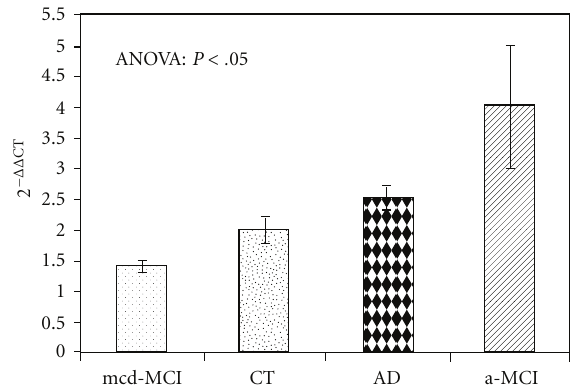
Figure 1: A 2A R mRNA levels (mean values ± standard error) in PBMCs from 41AD, 10 a-MCI, 49mcd-MCI, and 46 control (CT) subjects quantified by the 2 − ΔΔ Ct method. Bonferroni post hoc: a- MCI versus controls and mcd-MCI patients ( P < .